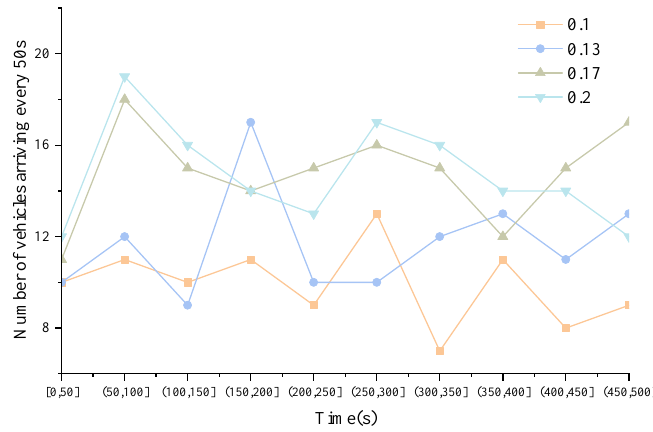
Figure 10. Number of vehicles arriving at the intersection every 50 s when the VARs are 0.1, 0.13, 0.17, and